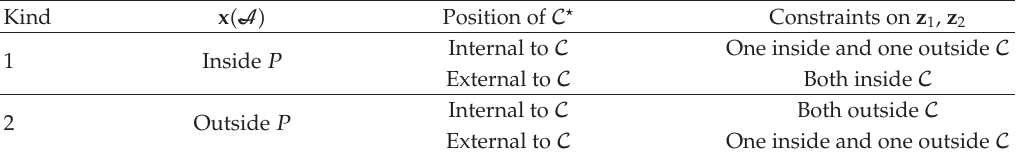
Table 2: Behaviour with respect to the second property, consequences on the map z (cid:11)→ x and corresponding constraints on the poles z 1 , z 2